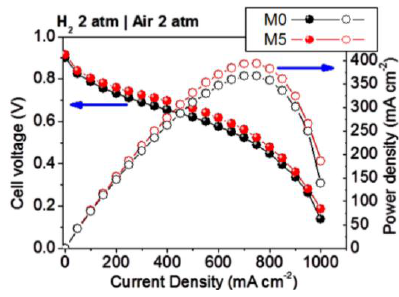
Figure 9. Fuel cell performances under 30% RH and 70 °C. H 2 -Air fed at 2 atm.